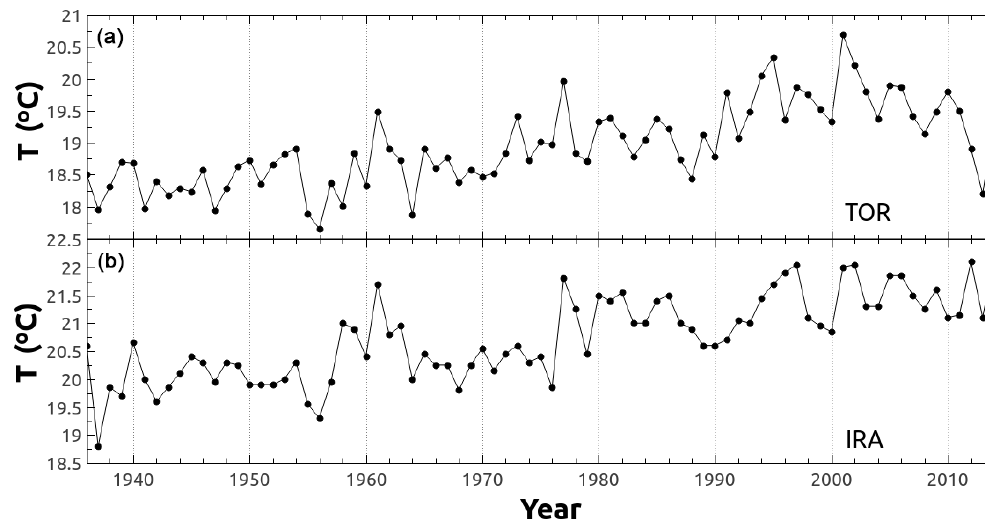
Figure 4. Time series of yearly average temperatures at southern Brazil weather stations: (a) TOR and (b) IRA.